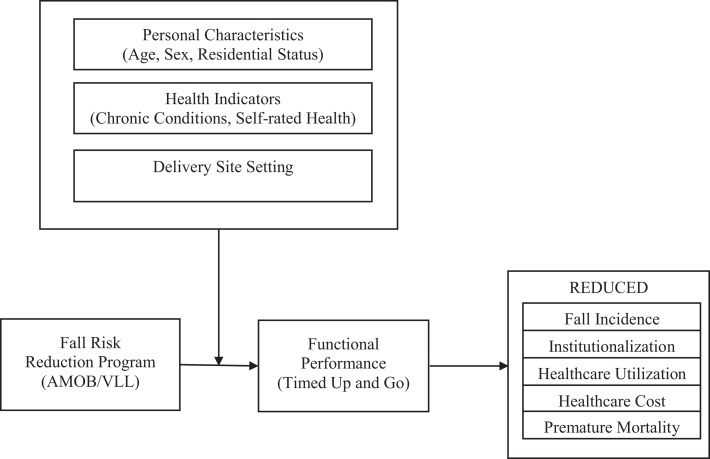
Conceptual model.